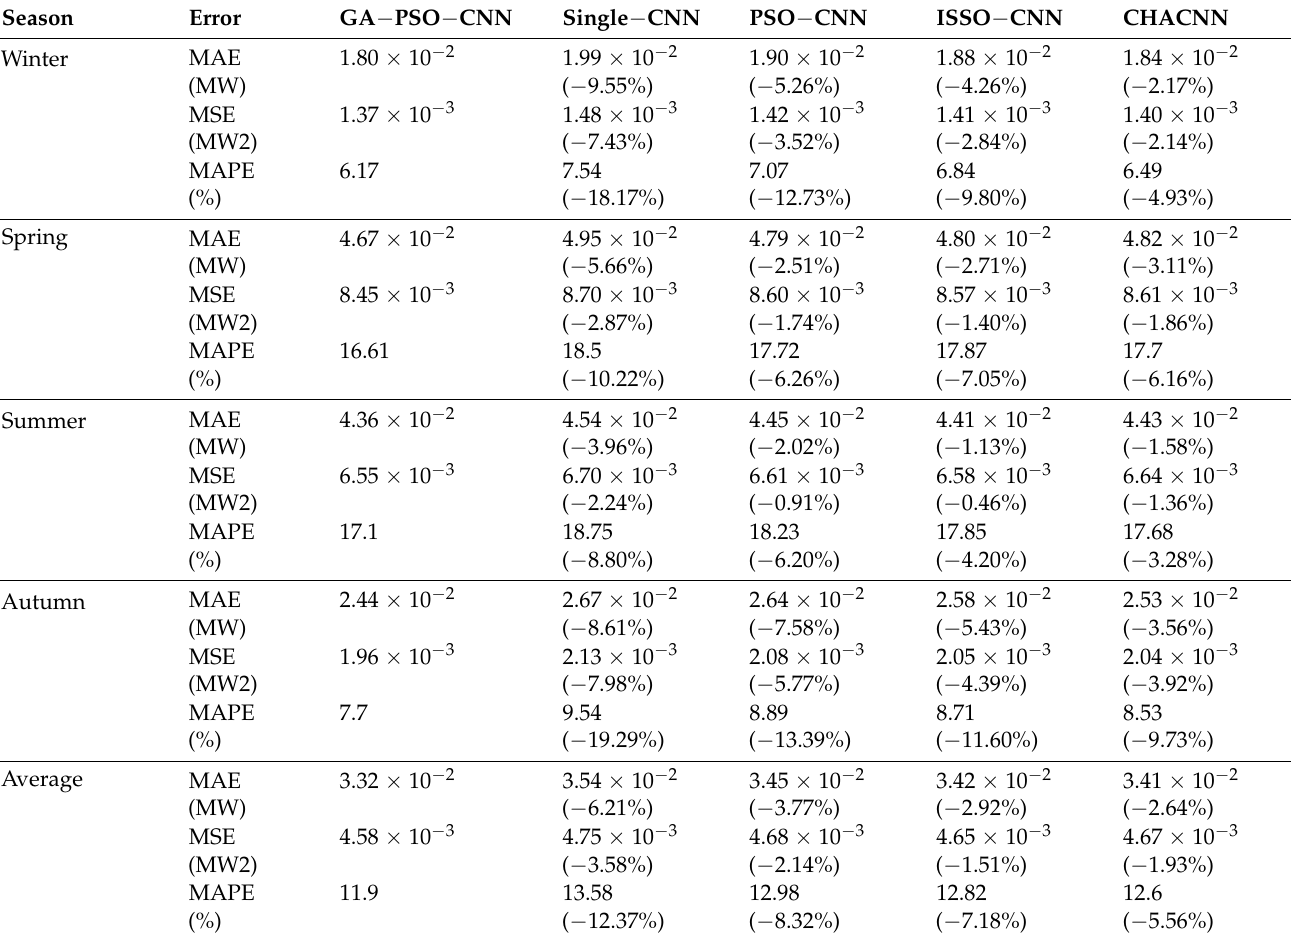
Table 3. Wind power forecast error for each model in different